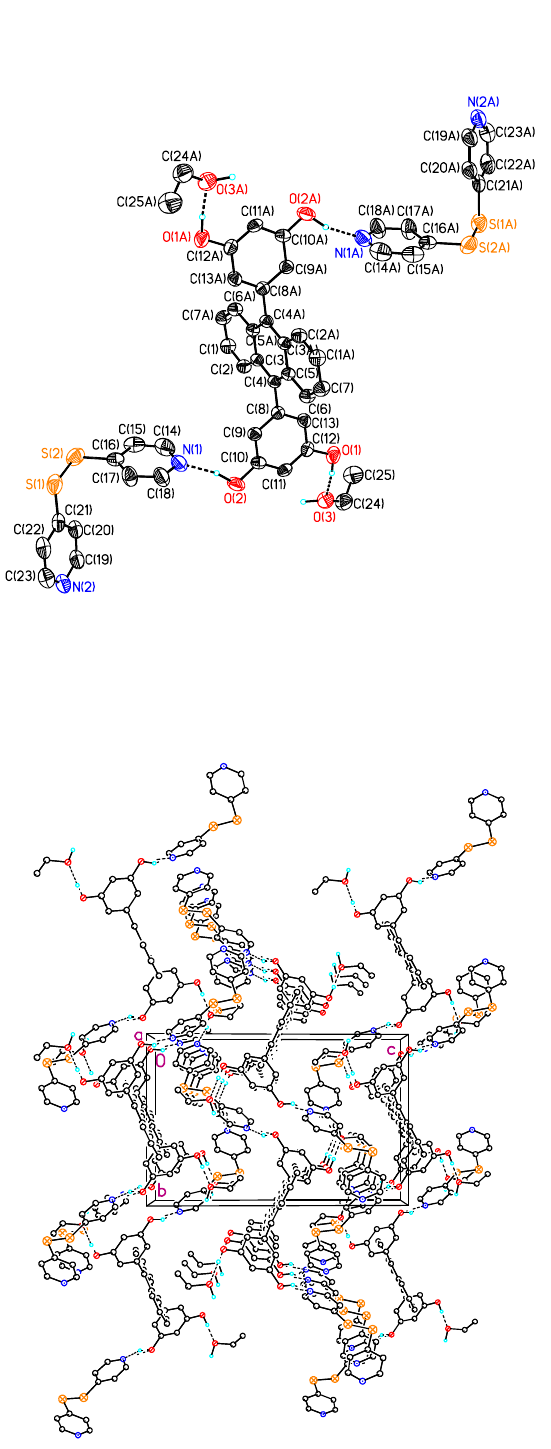
Figure 5 (a) The crystal structure of 5. Hydrogens were omitted for clarity. (b) The crystal-packing of 5 viewed down the a axis. Notice that 5 leads to a zigzag